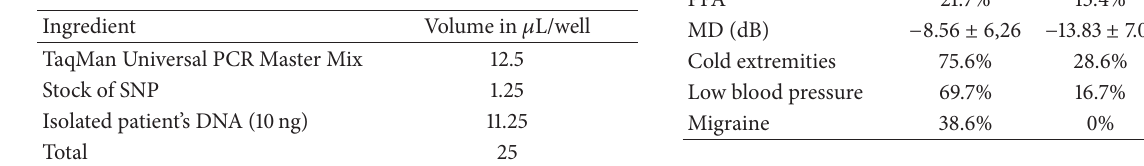
Table 2: Reaction mixture composition.